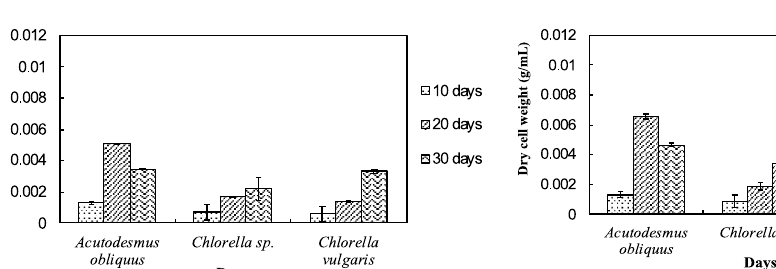
Fig. 1a. Dry cell weights of microalgae in normal medium.